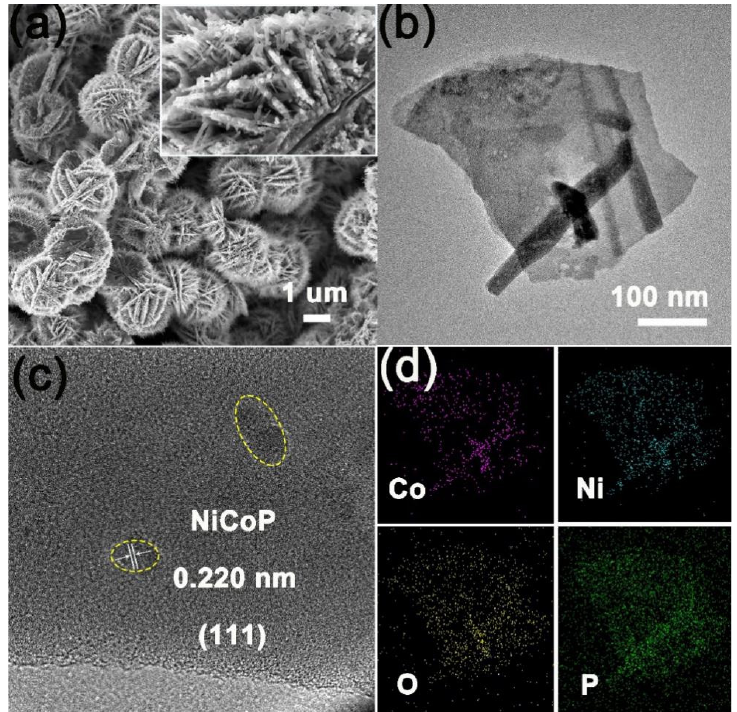
Figure 3. ( a ) SEM image of CoNiP NA/NF-2. ( b ) TEM image of CoNiP obtained from CoNiP NA/NF-2. Corresponding ( c ) HRTEM image and ( d ) EDS elemental mapping of Co, Ni, O and P.